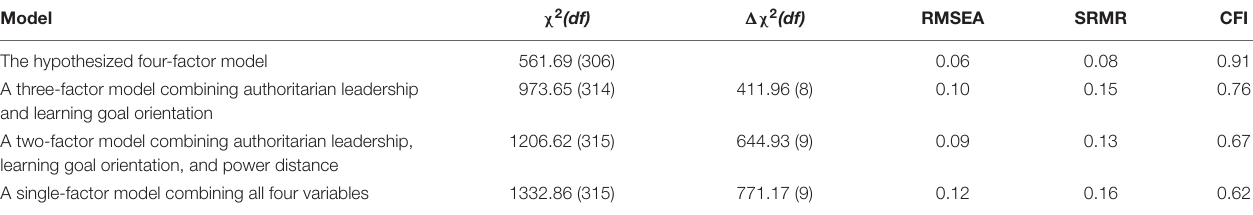
TABLE 1 | Comparison of factor structures.